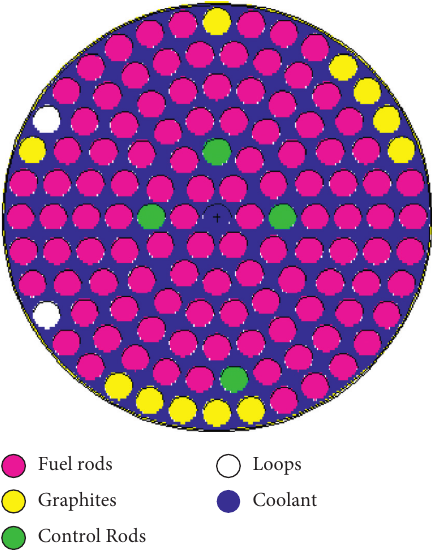
Figure 1: View of horizontal cross-section of TRIGA core simulated. Table 1: Structure of TRIGA